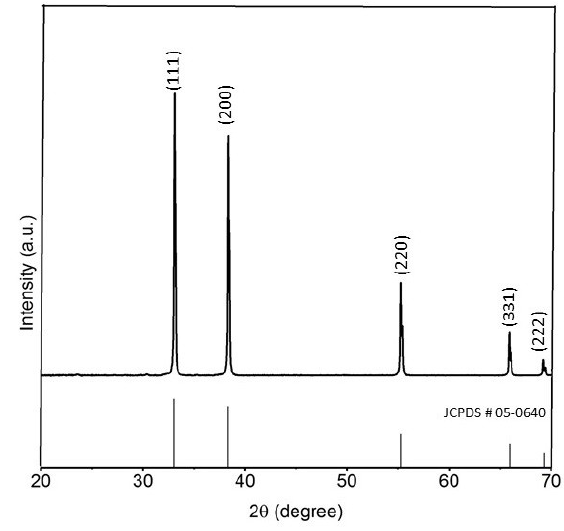
Figure 8. PXRD pattern of CdO nanospheres.